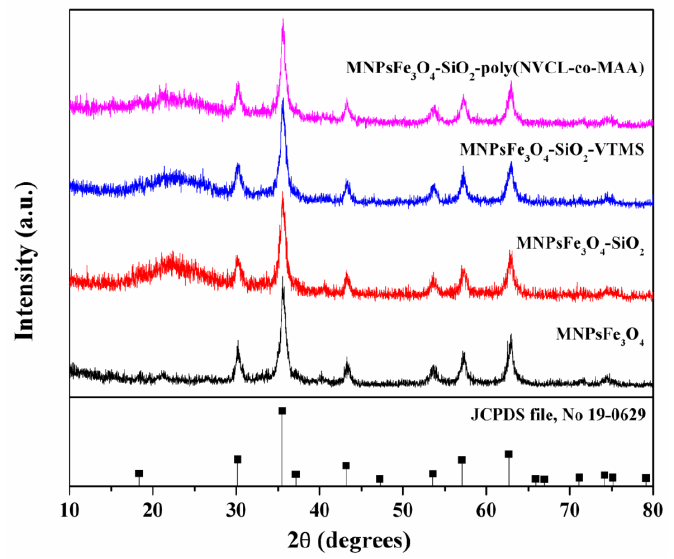
Figure 2. XRD patterns of MNPsFe 3 O 4 -SiO 2 , MNPsFe 3 O 4 -SiO 2 -VTMS, and MNPsFe 3 O 4 -SiO 2 -poly (NVCL-co-MAA) nanocomposites.